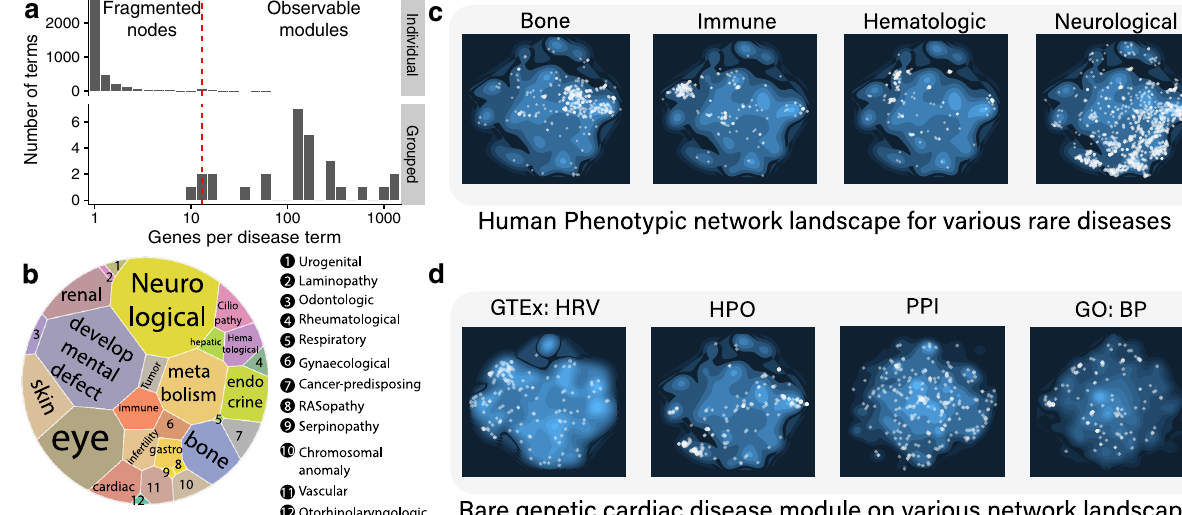
Fig. 2 Rare disease grouping and network mapping reveal network- and disease-speci fi c connectivity patterns. a Rare genetic diseases are typically associated with only a few genes and therefore remain fragmented on molecular networks. Grouping rare diseases by phenotypic similarity can overcome data scarcity and result in identi fi able disease modules, thus allowing for further network-based inspection. b Voronoi treemap showing the 26 rare genetic disease groups used in this study. The size of each disease group is proportional to the number of associated genes. c Network landscape obtained using the node2vec embedding algorithm. Network distances between genes are preserved in the embedding and illustrate differential modularity of different rare disease groups on the Human phenotype similarity network layer. The bright dots represent disease associated genes and the blue contour map represents all genes in a network. d Localization of the rare cardiac disease group on different network